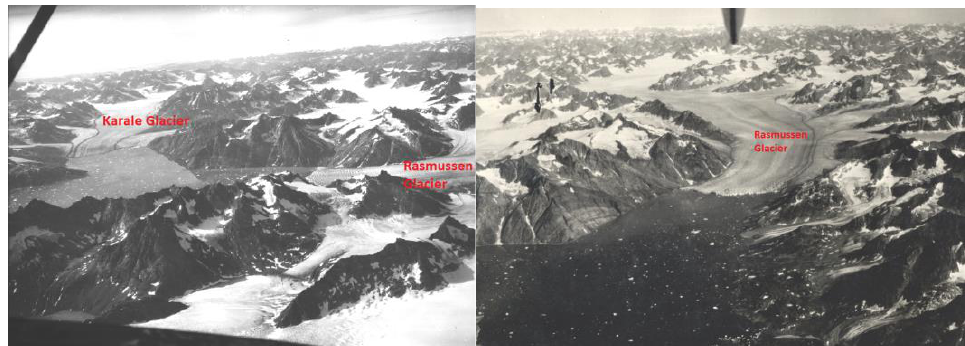
Figure 2. The Knud Rasmussen Glacier in a photo from the Danish Greenland expedition (the sev- enth Thule Expedition 1932–1933); (photo: the Arctic Institute,